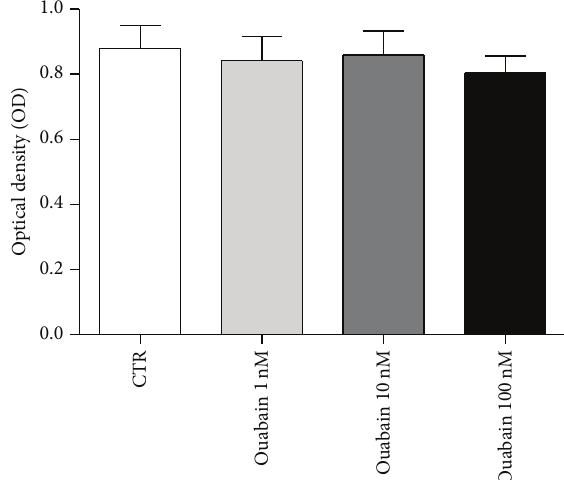
Figure 6: Effect of the ouabain on the viability of peritoneal macrophages. Analysis of macrophage viability was assessed by MTT reduction method. The graph represents the mean ± SEM of at least three independent experiments performed in